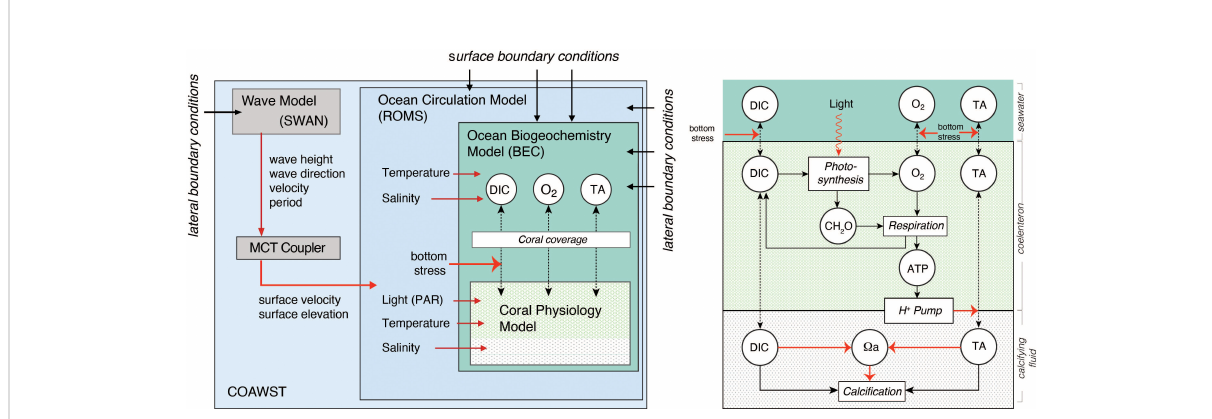
FIGURE 2 Diagrammatic depiction of the fully coupled physical-biogeochemical-ecological model of the Moorea North Shore Reef system. The model consists of four compartments, i.e., the wave model SWAN, the ocean circulation model ROMS, which are parts of COAWST, the ocean biogeochemical model BEC, and a coral physiology model (see text for details). Metabolic processes in the coral physiology model on the right hand side are shown in rectangles, while the considered state variables in each model are indicated in circles. Dashed lines indicate diffusive fl uxes. Red arrows indicate controlling in fl uences (e.g., the control of bottom stress on the diffusive exchange between corals and the seawater) or information transfer (e.g. the transfer of temperature and salinity from ROMS to BEC, or from ROMS to the coral physiology